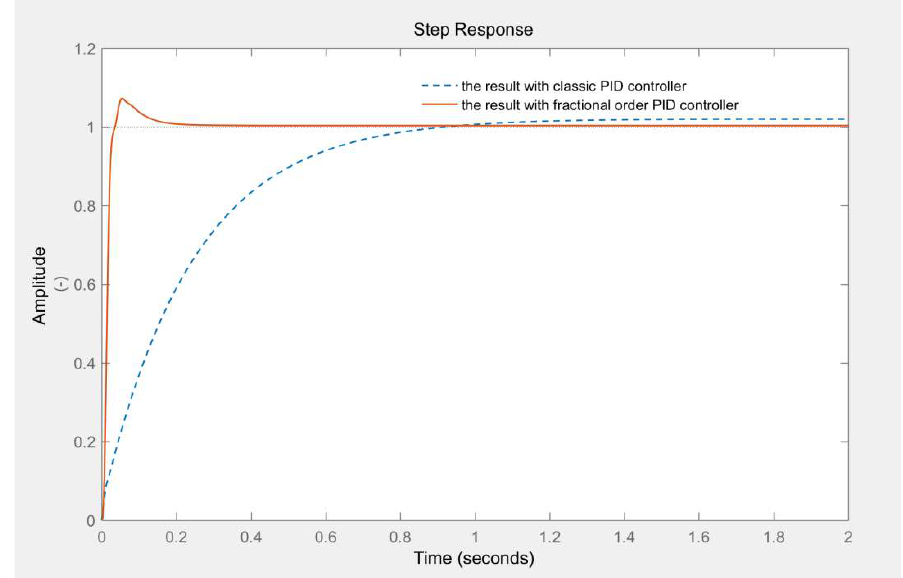
Figure 1. Comparison of the step responses of the two PID controllers.